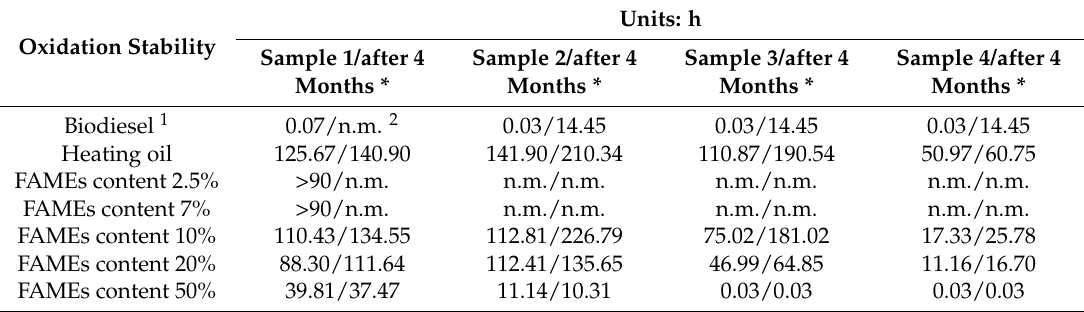
Table 7. Experimental results for the oxidation stability of the tested